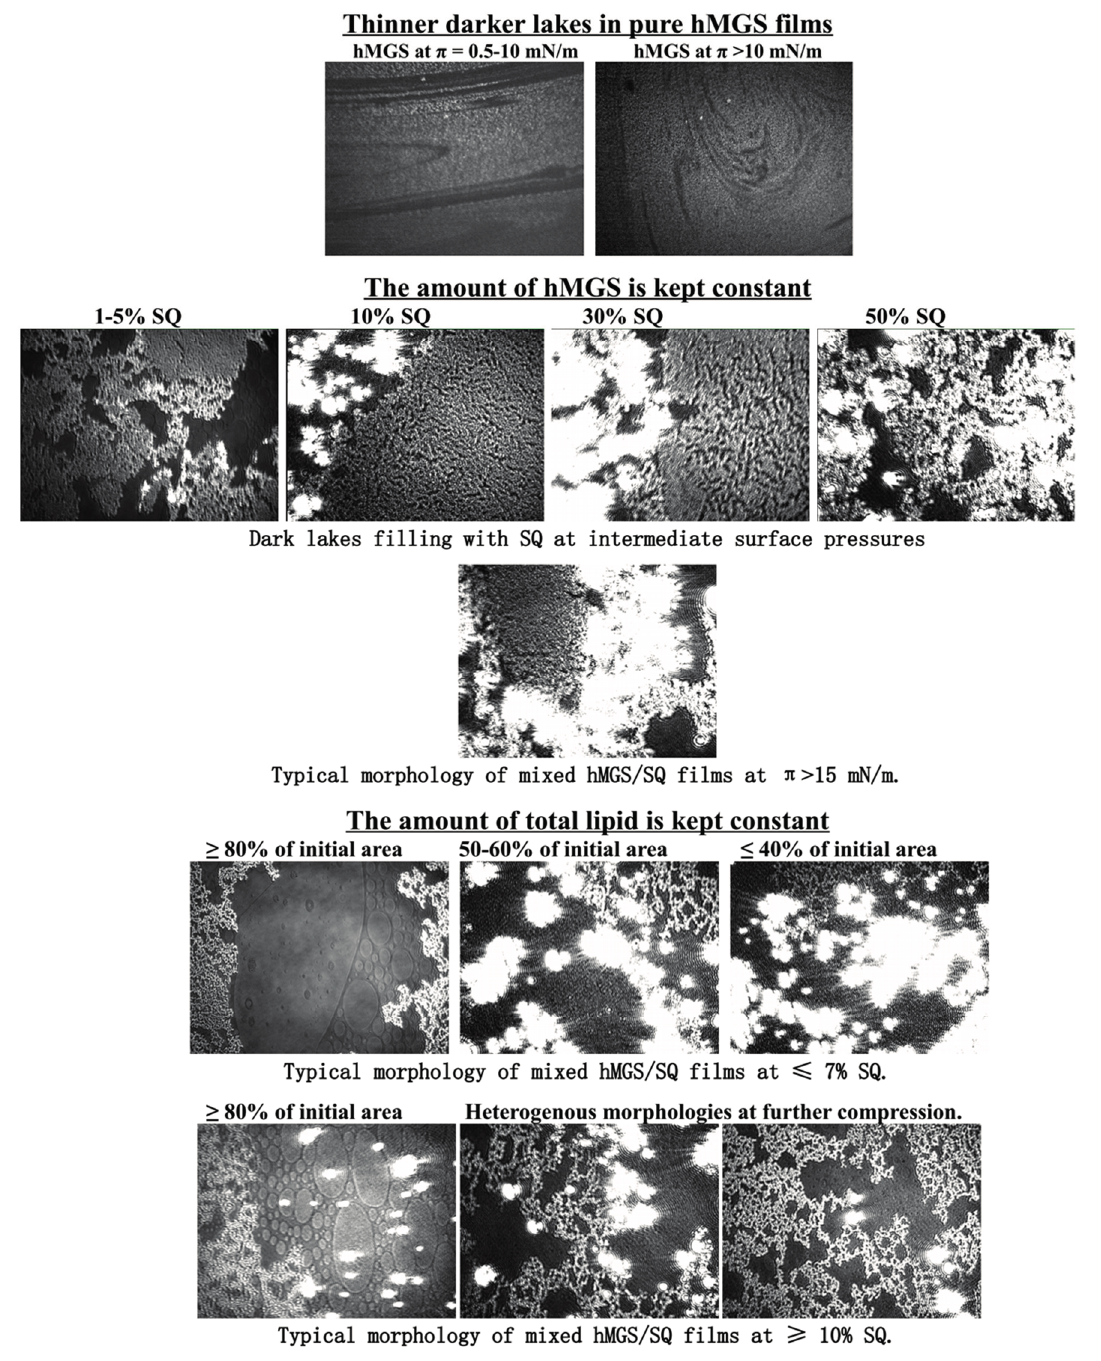
Figure 7. UltraBAM images (720 µm × 400 µm) of hMGS/SQ surface layers at various degrees of